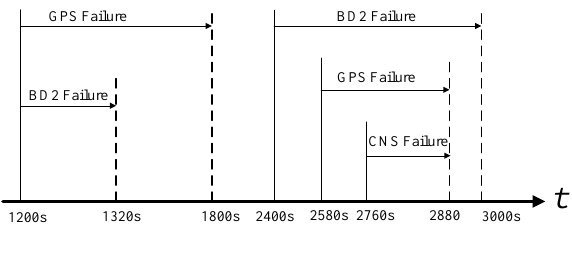
Figure 12. Failure timing sequence. Table 6. Initial error.